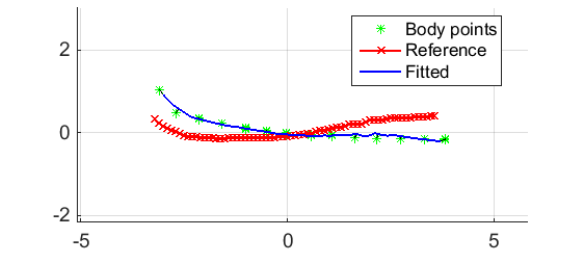
Figure 5. Reference profile fitted to point cloud at one profile